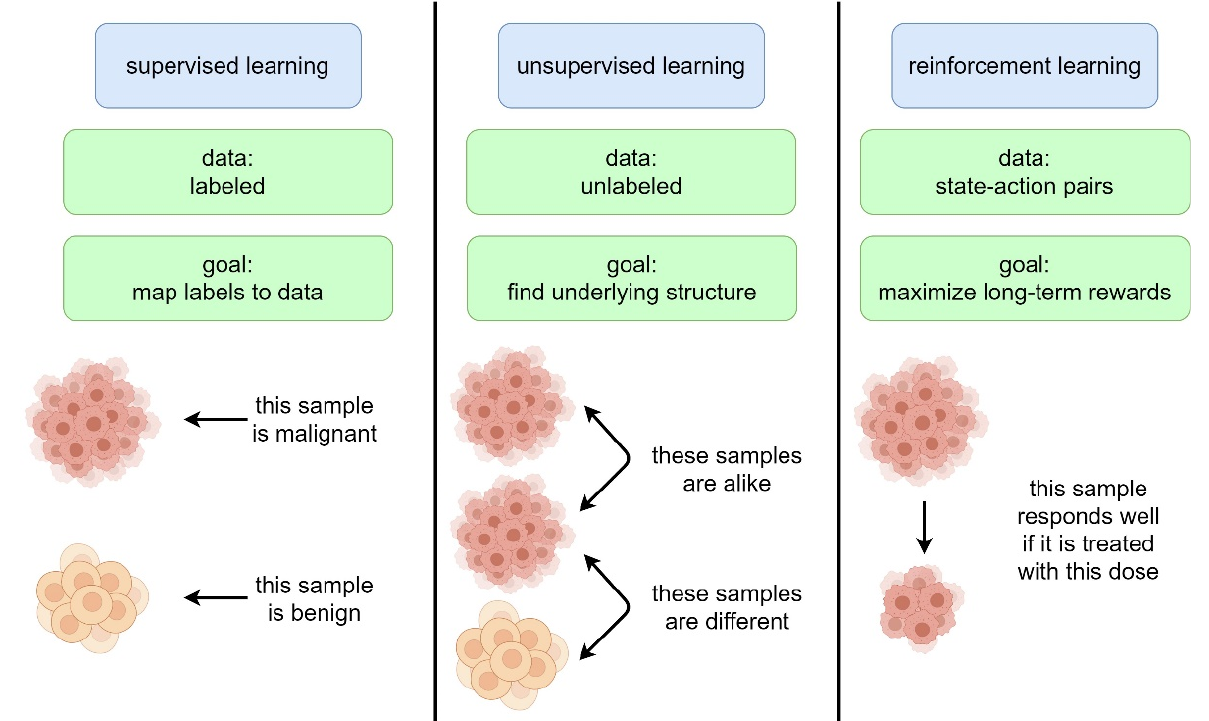
Figure 1. Main differences between machine learning techniques.